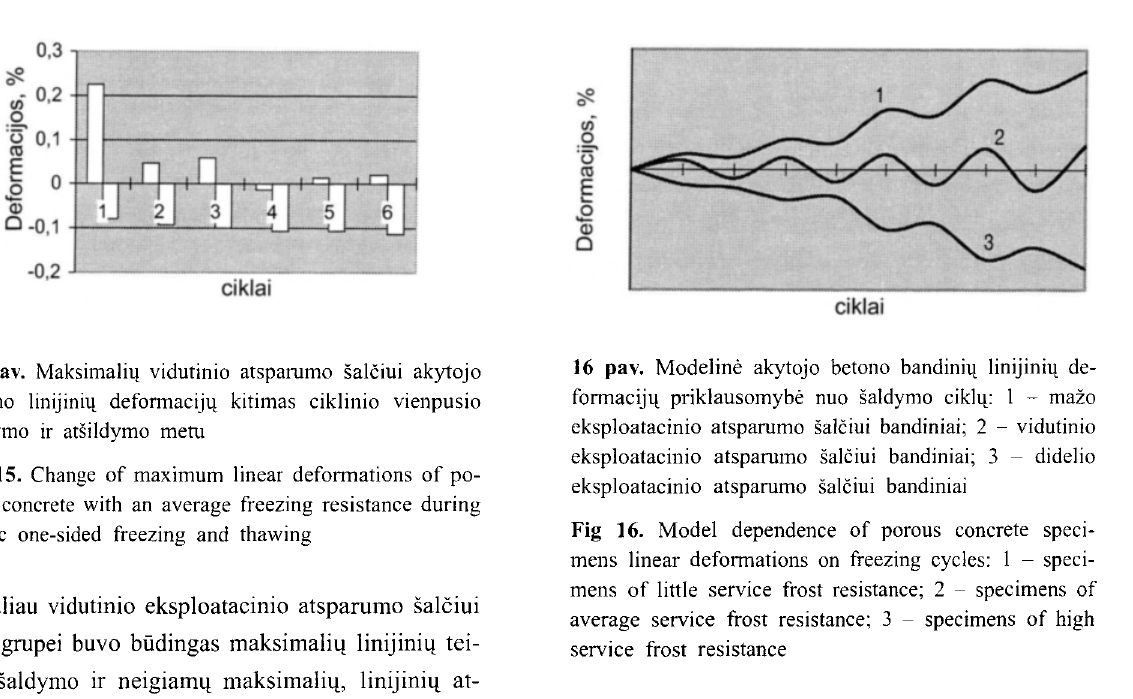
Fig 16. Model dependence of porous concrete speci mens linear deformations on freezing cycles: I ~ speci mens of little service frost resistance; 2 ~ specimens of average service frost resistance; 3 ~ specimens of high service frost resistance skirtingai. Galime tvirtinti, jog, kai bandiniuose